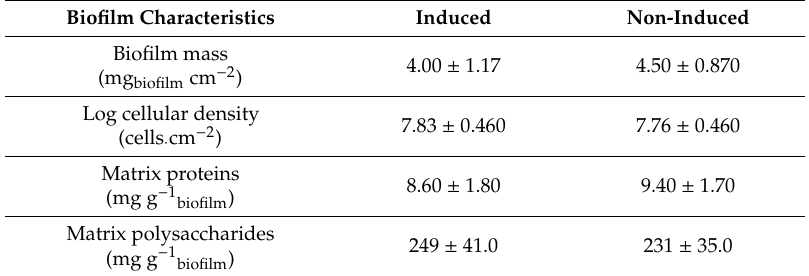
Table 1. Extracellular polymeric substance (EPS) analysis of induced and non-induced biofilms after 7 days of